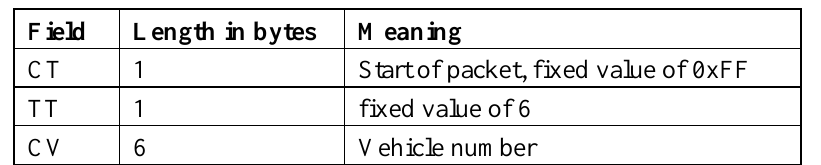
Table 9. Datagram